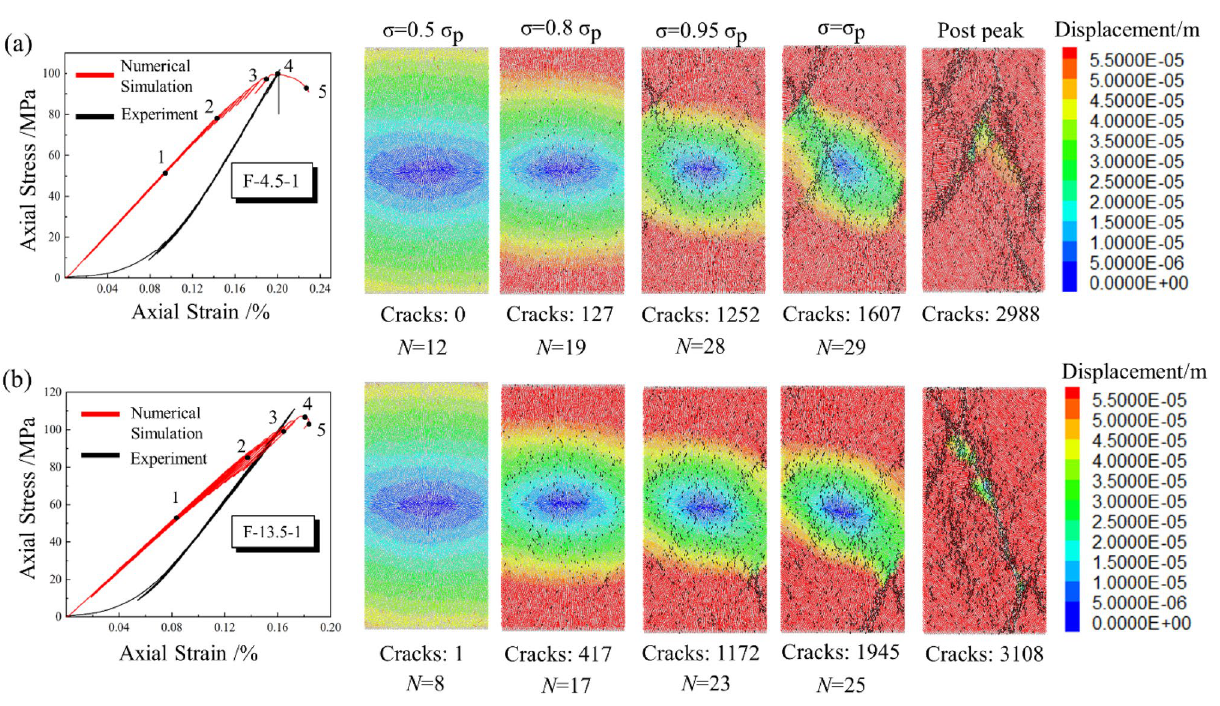
Figure 9. The evolution of displacement field ( N = 1): ( a ) A = 4.5 MPa; ( b ) A = 13.5